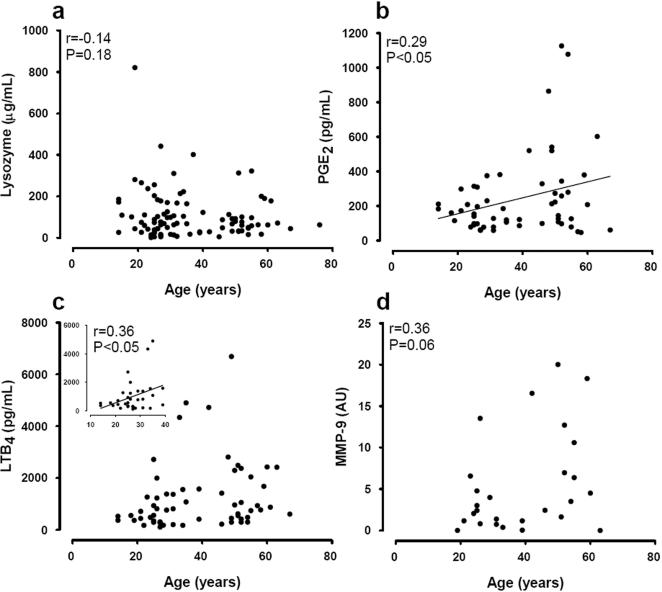
Relationship between age and mediators of inflammation in saliva from healthy subjects.Panel a: lysozyme activity, b: PGE2, c: LTB4 (with inset showing ≤40 years) and d: MMP-9 activity. Diagonal lines are the regression correlations when shown to be significant.